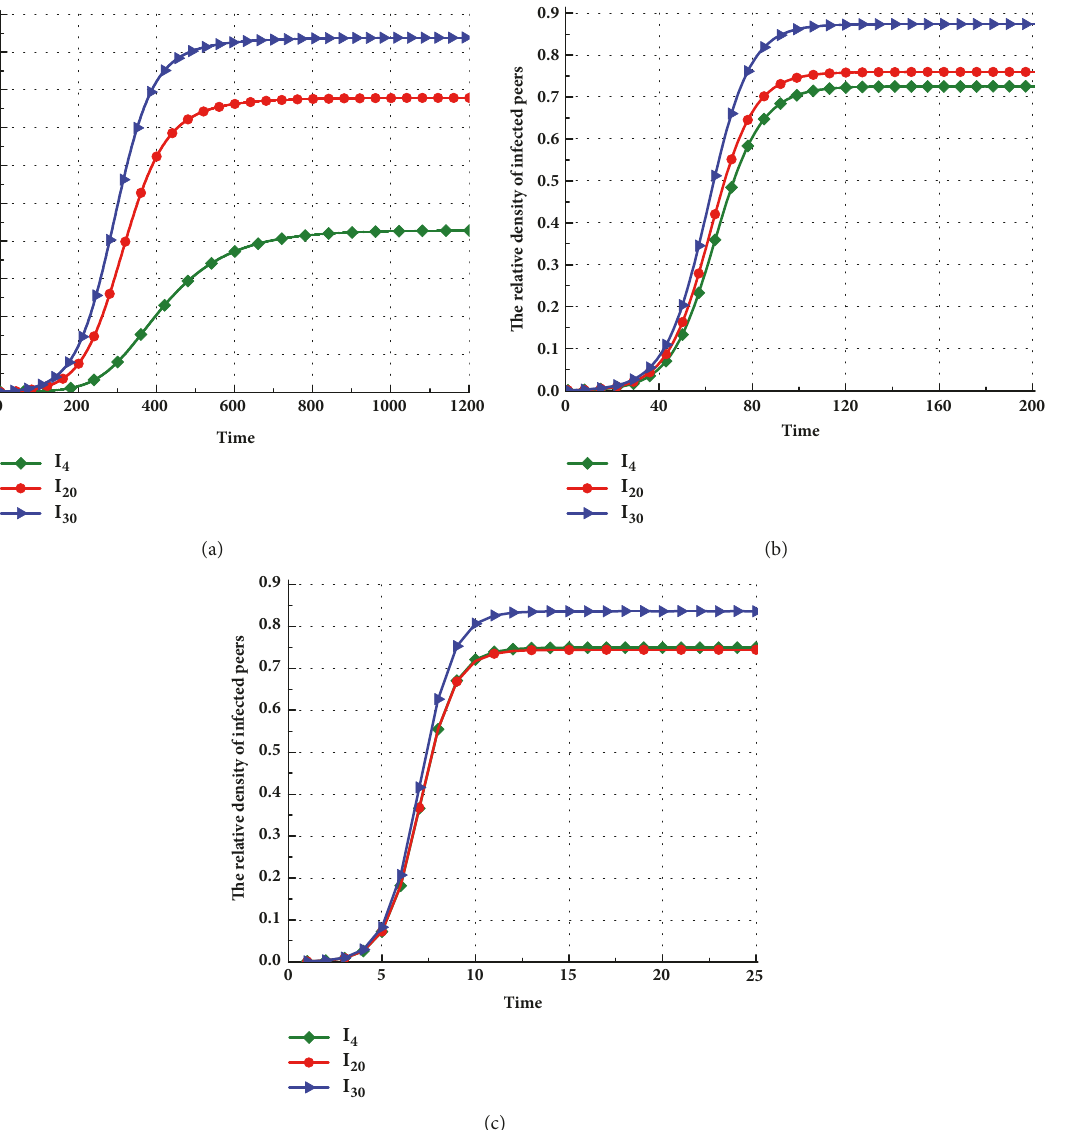
Figure 5: The change of the relative densities of infected peers with degree 𝑘 = 4,20 and 30 for different 𝑑 when 𝑅 0 = 3.9685 . (a) d=1; (b) d=2; (c)